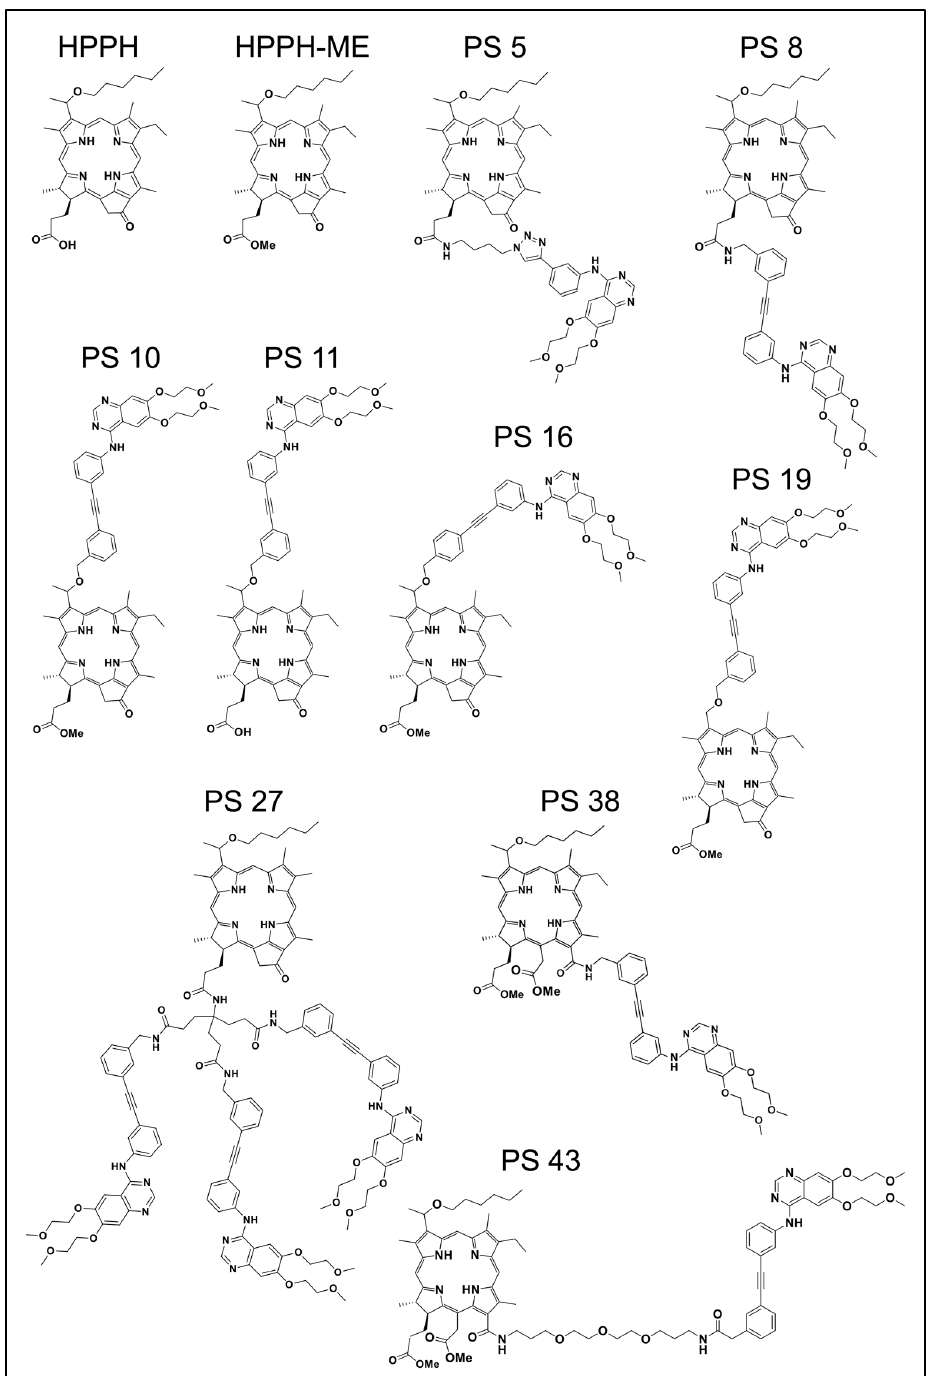
head and neck (HN) tumor epithelial cells (T-EC) and tumor-associate fibroblasts (T-Fb) (Figure 2; example of tongue tumor-derived HNT1 cells combined with carboxyfluorescein succinimidyl ester (CFSE)-tagged HN tumor stromal cells). Incubations for 30 min demon- strated the immediate and high-level entry of HPPH by diffusion into both cell types and incubation for 24 h yielded maximal level of HPPH accumulation. The subcellular site of deposition is mitochondria/ER, which is clearly distinct from lysosomal compartment (Figure 3A, left 2 panels). The relative retention of HPPH during the subsequent 48 h chase period defined the cell type specificity (Figure 2).